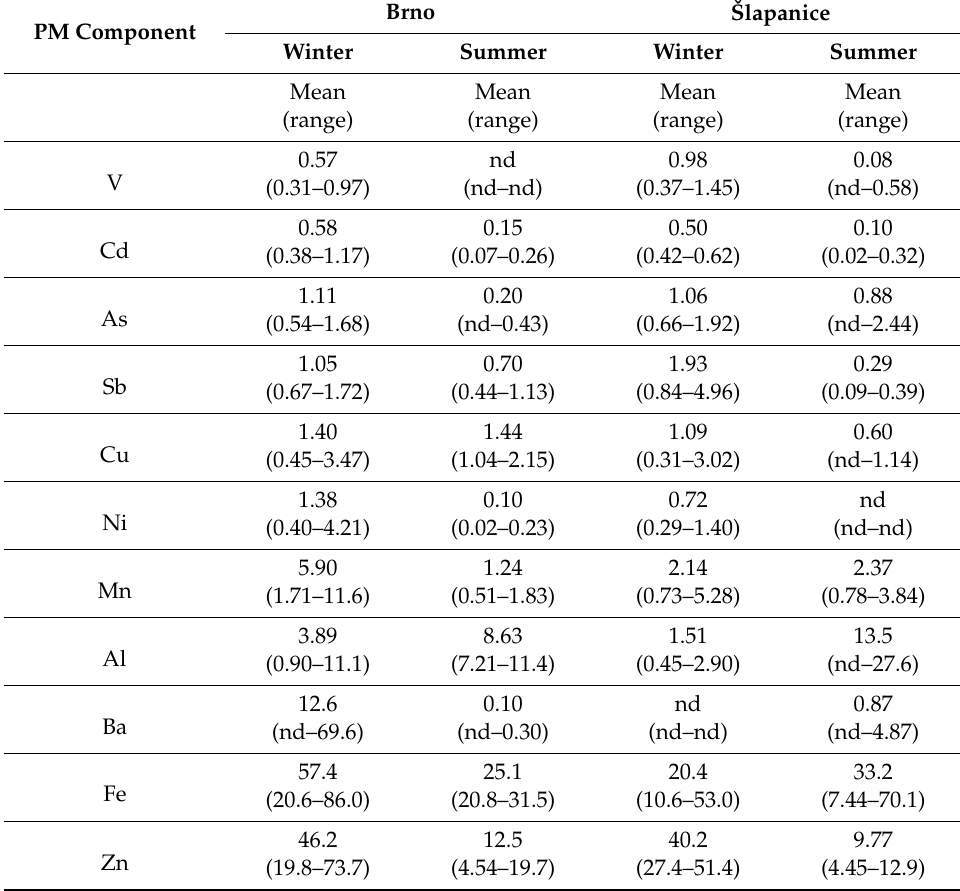
Table 4. Summary of concentrations of elements and water-soluble ions (ng m − 3 ) in PM 1 aerosols collected during winter and summer campaigns in Brno and Šlapanice in